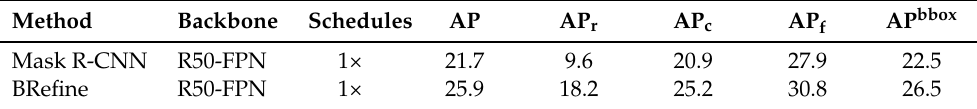
Table 7. Results on the LVISv1.0 validation set. All models were trained with a 1 schedule, and the hyperparameters were kept the same as those of MMDetection [22] except that the learning rate was set to 0.0075.